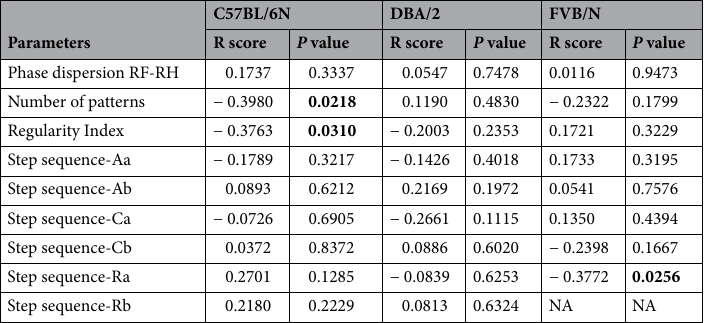
Table 3. Correlation between the body weight and gait parameters. The correlation was measured using Pearson’s correlation coefficient for each strain. The bold values indicate significant